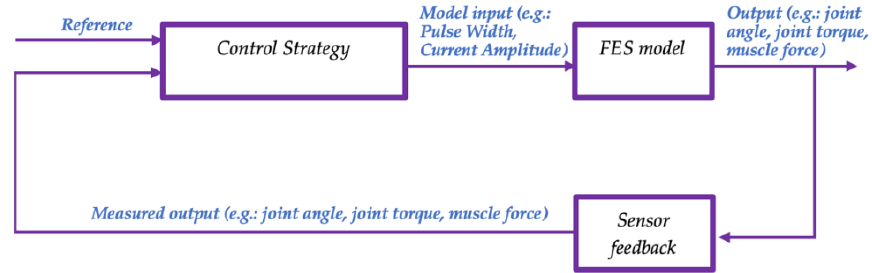
Figure 2. Link between the three concepts in an LLC in the context of FES: (1) FES model (2) Sensor feedback (3) Control strategy.